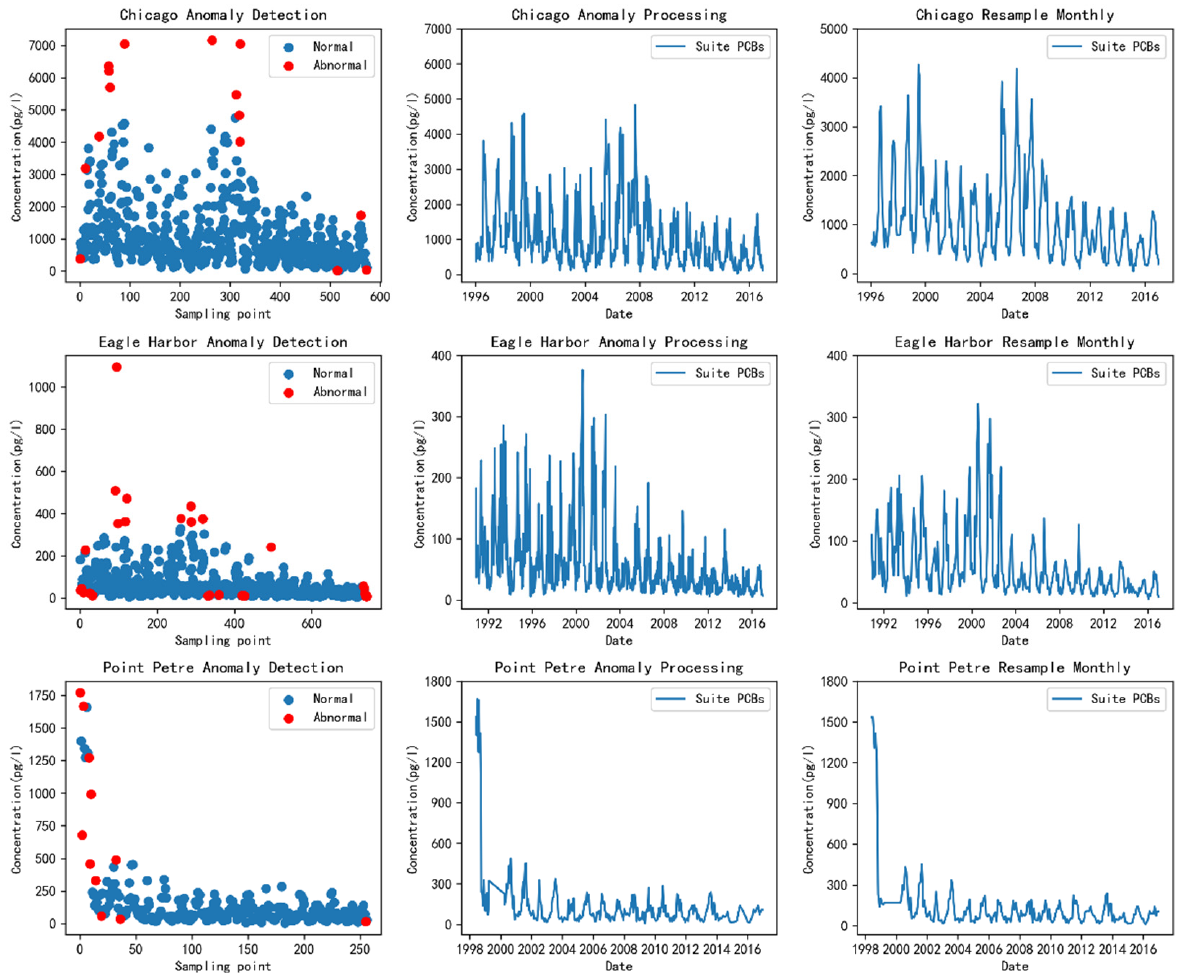
Figure 5. Anomaly detection, anomaly processing and monthly resampling results of three sites.